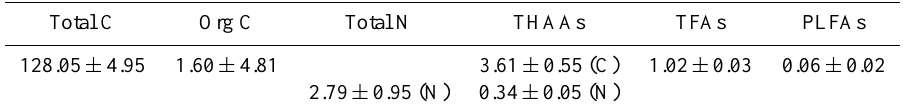
Table 2. Biogeochemical composition of L. pertusa : Concentration of total carbon (Total C), organic carbon (Org C), total nitrogen (Total N), total hydrolysable amino acids (THAAs), total fatty acids (TFAs) and phospholipid-derived fatty acids (PLFAs) in coral samples. Values are presented in (mgCg − 1 DW coral ± SD) and (mgNg − 1 DWcoral ± SD), respectively. Total C Org C Total N THAAs TFAs PLFAs 128.05 ± 4.95 0.34 ± 0.05 (N)